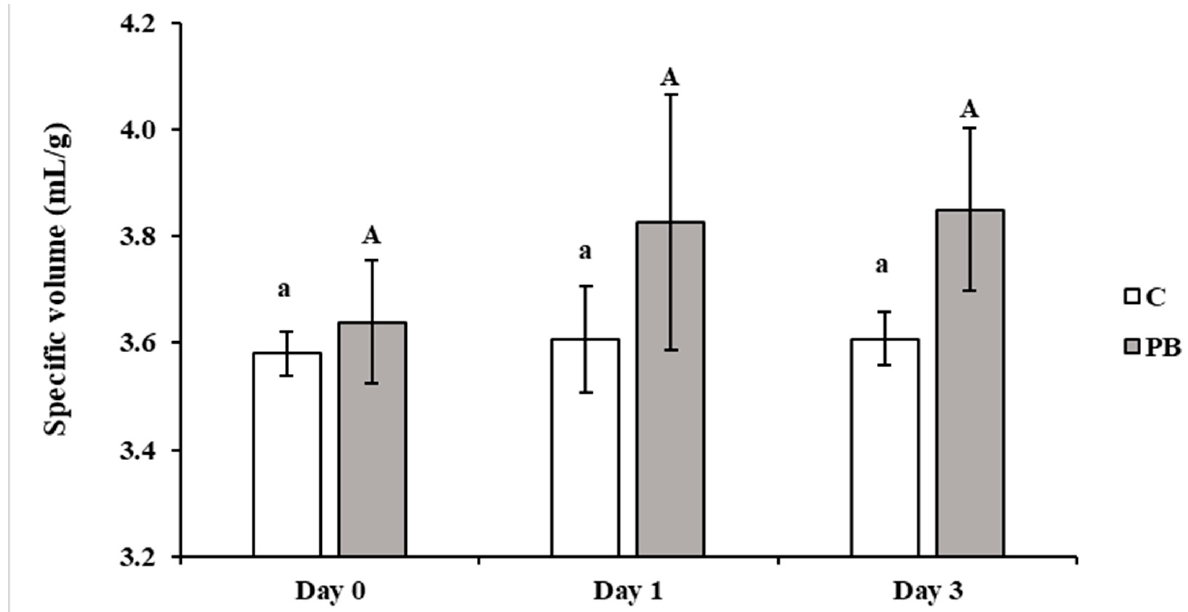
Figure 1. Specific volume (mL/g), mean and standard deviation, of control (C) and parchment supplemented (PB) bread loaves. Different small and capital letters, for C and PB, respectively, in-dicate significant differences ( p ≤ 0.05) during